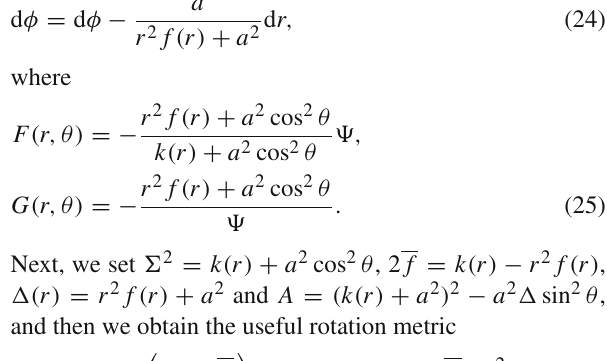
Fig. 1 The behavior of dark matter density ρ with radial distance r . Themodelingparametersare θ = π/ 2, ω = 0, R s ( or R and R c ) = 10, r 0 = 1, ρ s ( or ρ 0 ) = 0 . 05 and a = 0 .